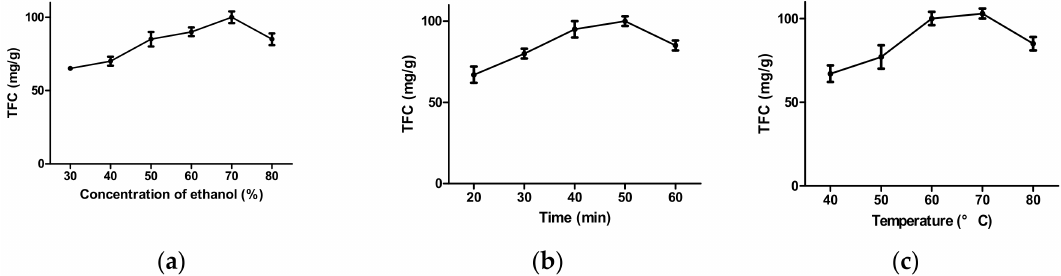
Figure 1. The effects of ( a ) concentration of ethanol; ( b ) extraction time; and ( c ) extraction temperature on the total flavonoid content (TFC) of the extract ( N =